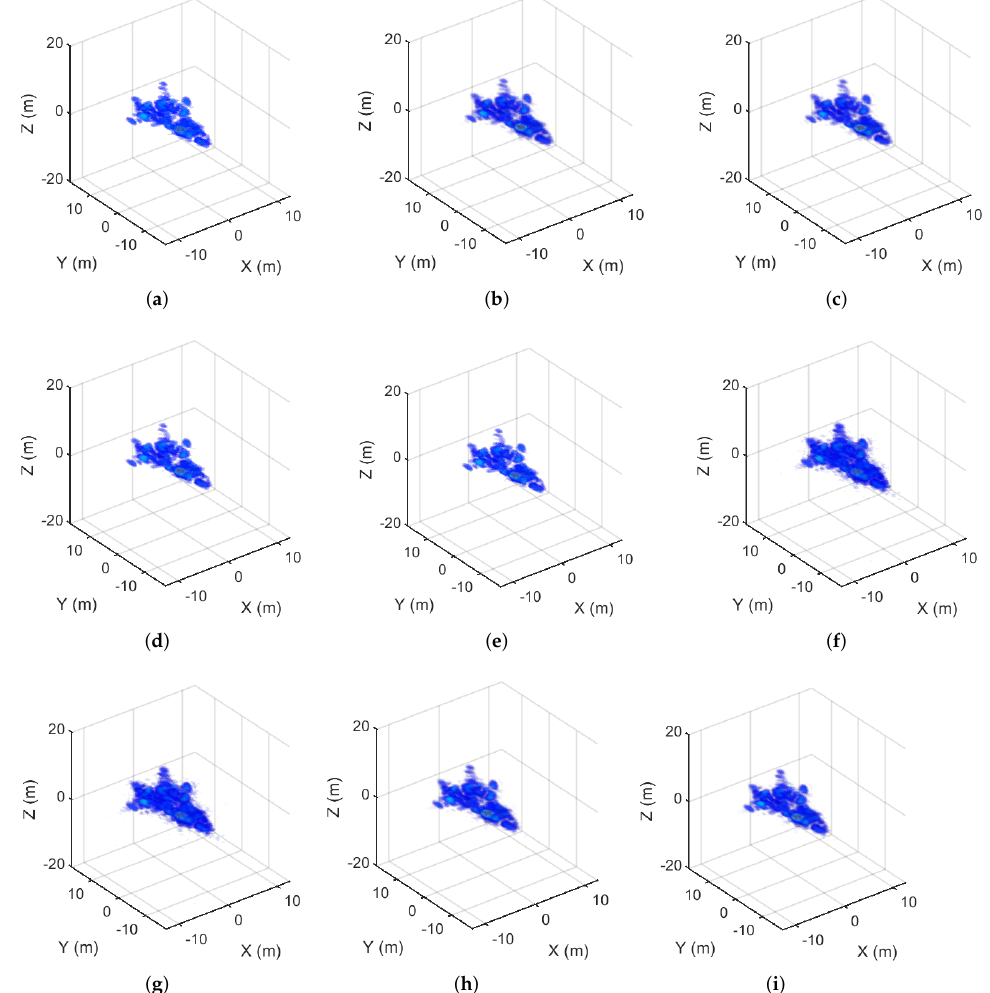
Figure 11. The imaging results of the aircraft corresponding to fully sampled data. ( a ) The The IST result. ( b ) The MM- L 1 result with PI. ( c ) The MM- L 1 result without PI. ( d ) The MM- L 1/2 result with PI. ( e ) The MM- L 1/2 result without PI. ( f ) The MM- L 0 result with PI. ( g ) The MM- L 0 result without PI. ( h ) The GMM- L 0.8 result with PI. ( i ) The GMM- L 0.8 result without